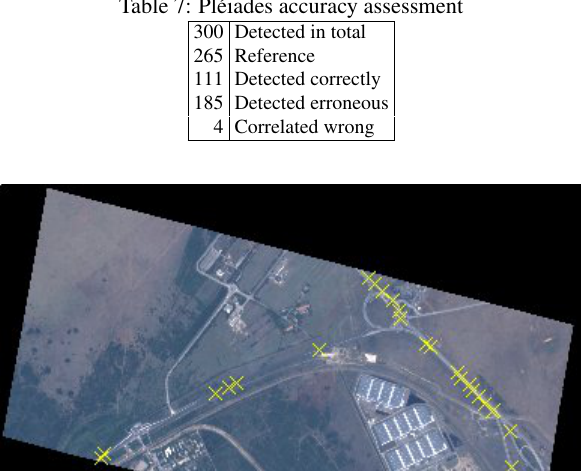
Table 7: Pl´eiades accuracy assessment